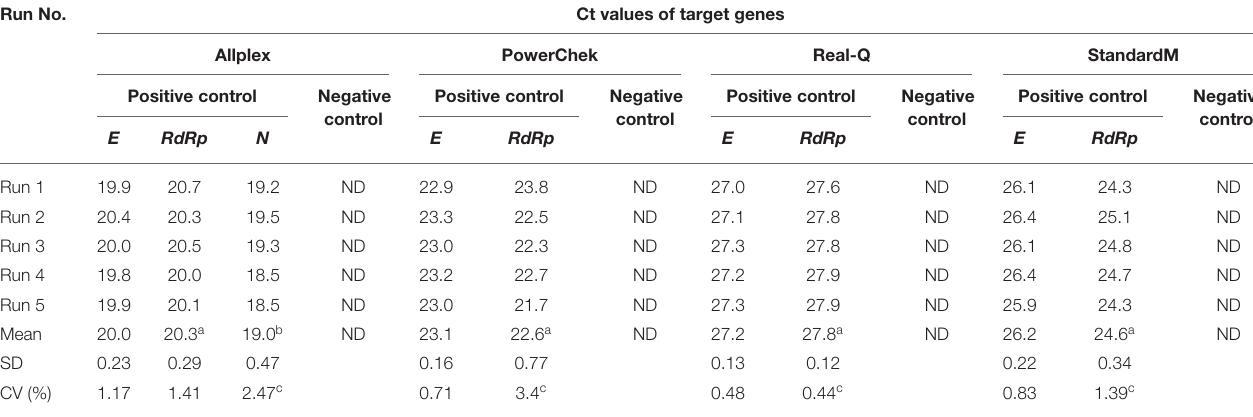
TABLE 3 | Precision tests for four commercial kits. Run No. Ct values of target genes